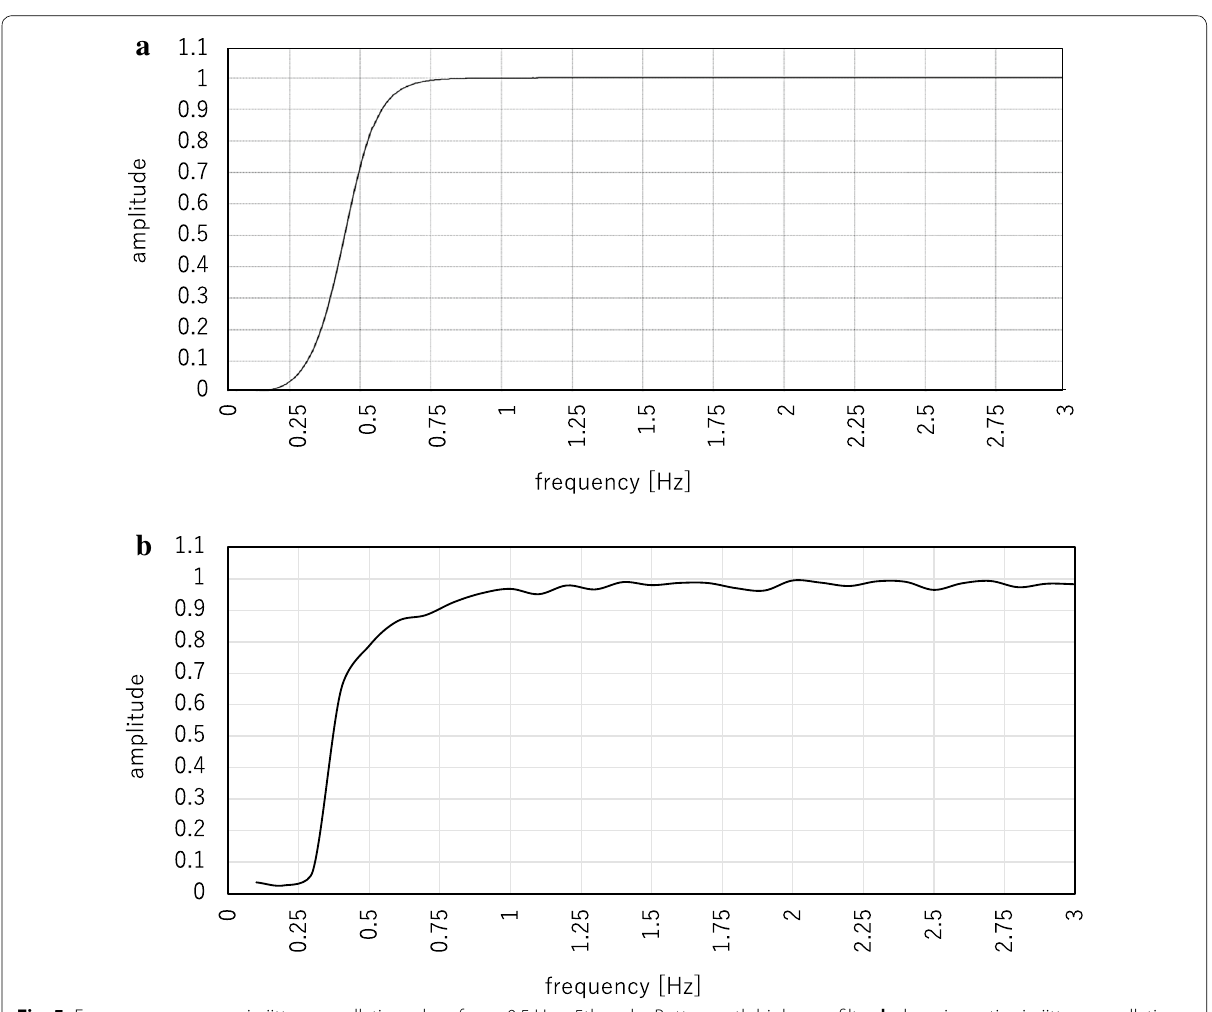
Fig. 5 Frequency responses in jitter cancellation when f cut = 0.5 Hz a 5th-order Butterworth high-pass filter, b damping ratios in jitter